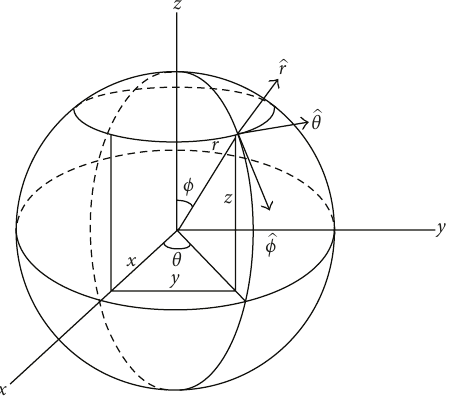
Figure 2: Unit vectors in spherical